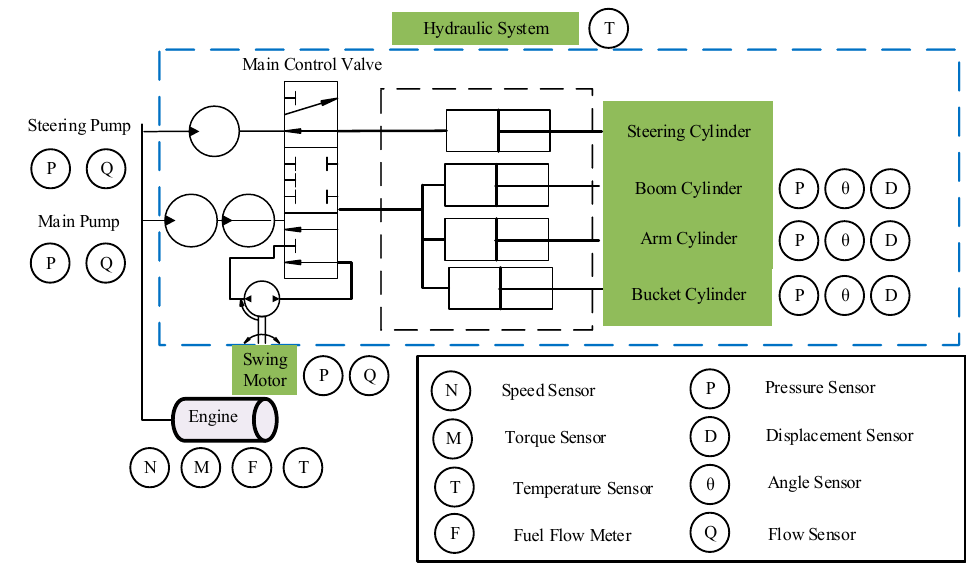
Figure 7. Data required for each component of excavator.